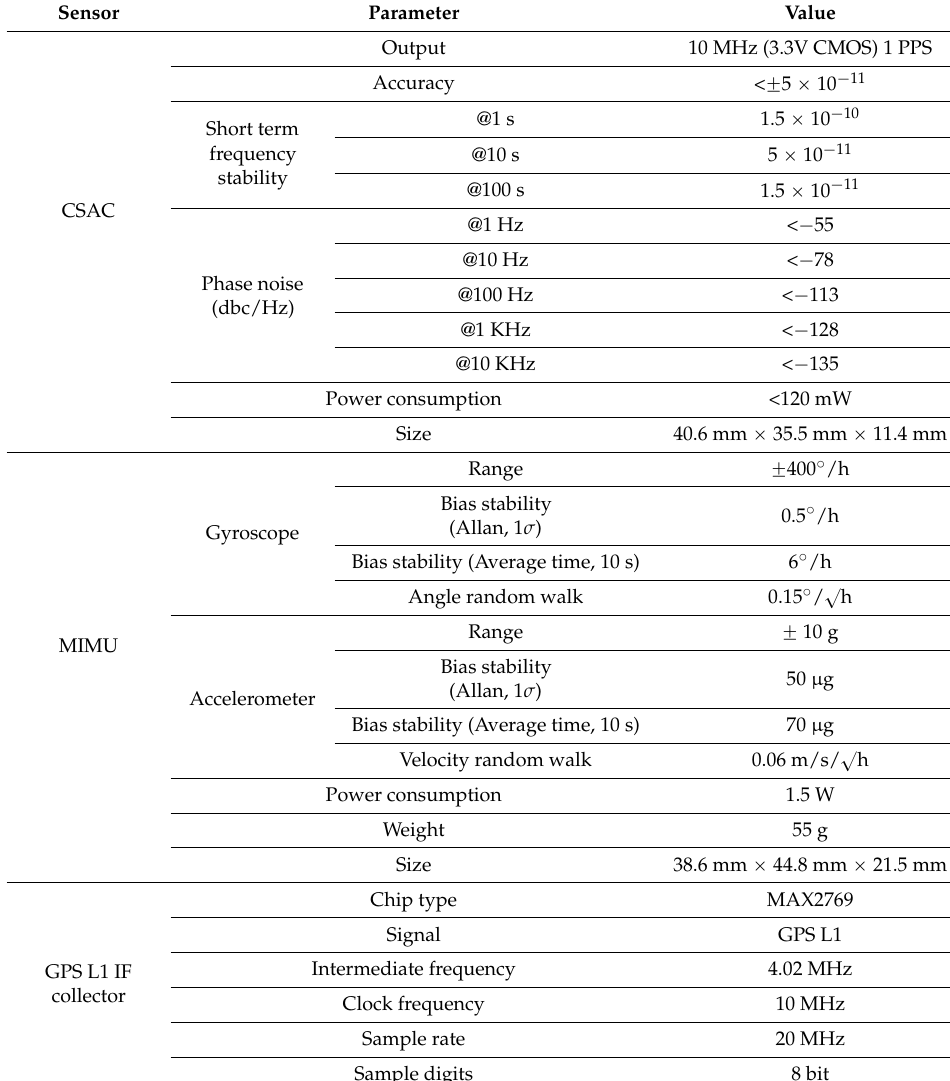
Table 2. Main parameters of sensor in the